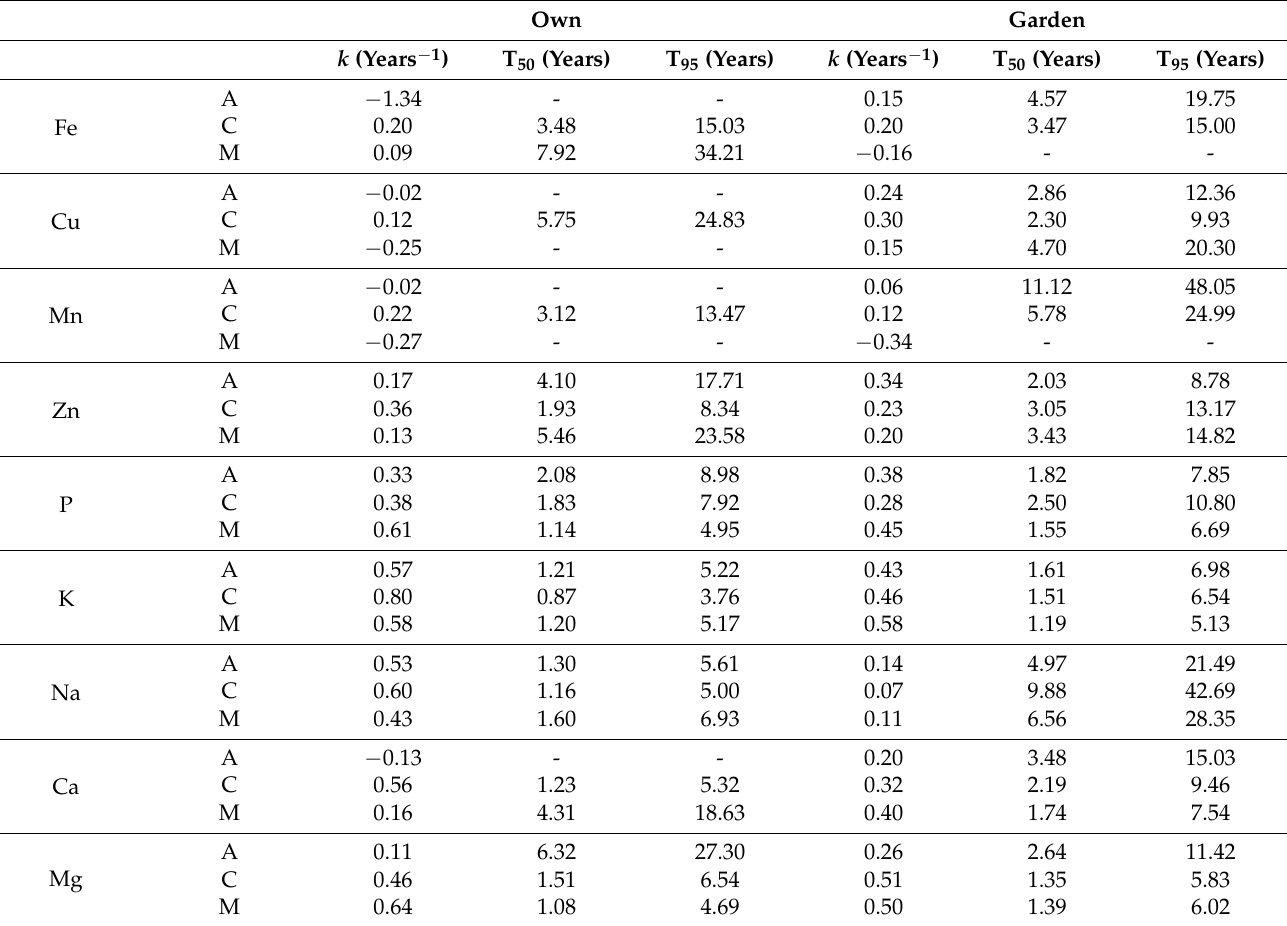
Table 3. Mean values of annual decay rate constant ( k ) and mean decay times to 50 (T 50 ) and 95% (T 95 ) of the initial macro-elements and micro-elements in all waste. Own